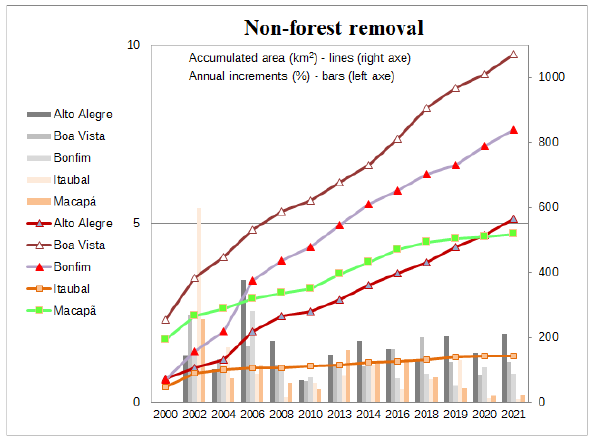
Non-forest removal outcomes within the municipalities of the pilot area. Accumulated area in km² is 6 illustrates the shown in lines (left axe) and annual increments in percentage (right axe). Source: elaborated by authors (Almeida et al.2022).